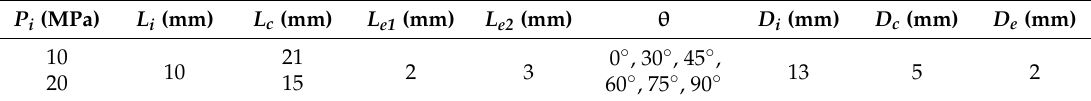
Table 3. Geometrical parameters of the tested organ-pipe